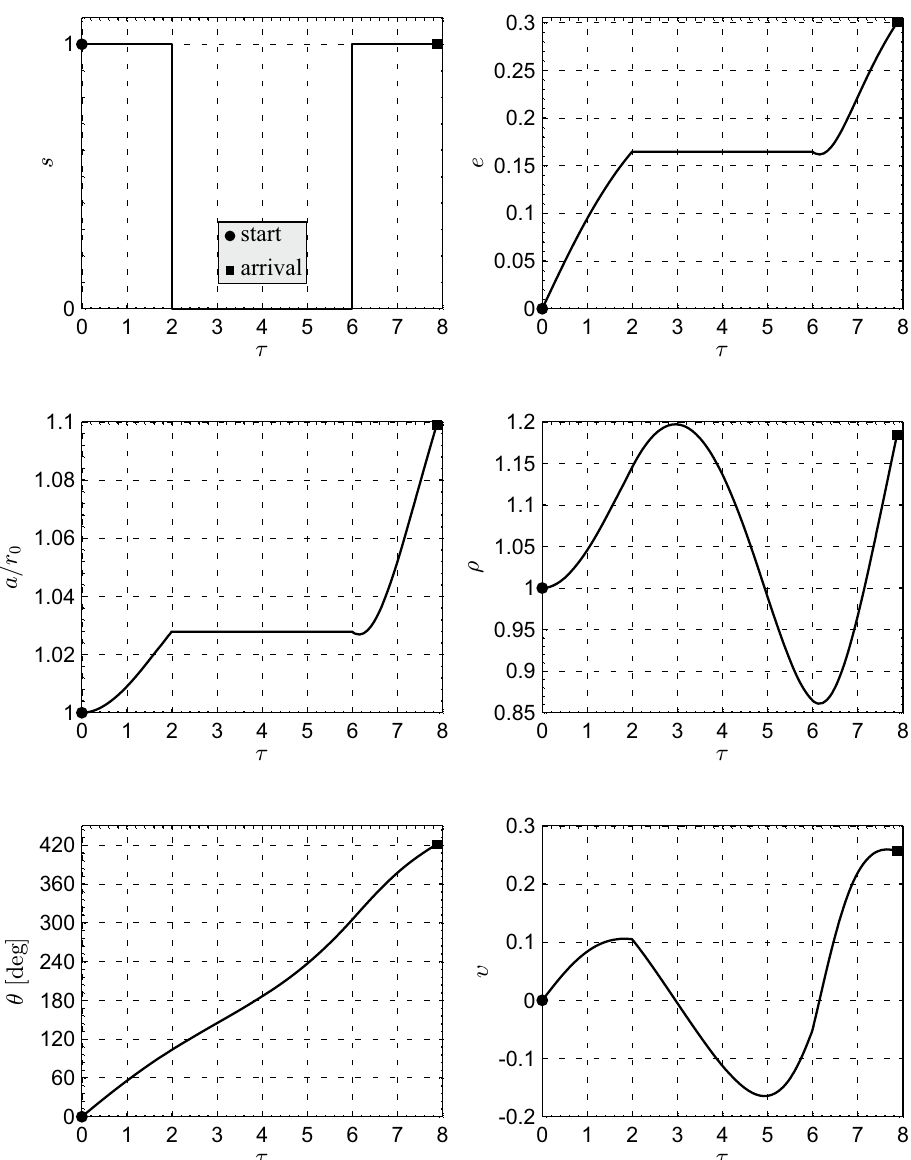
Figure 9. Optimal τ -variation of the spacecraft states when e f = 0.3 and β =